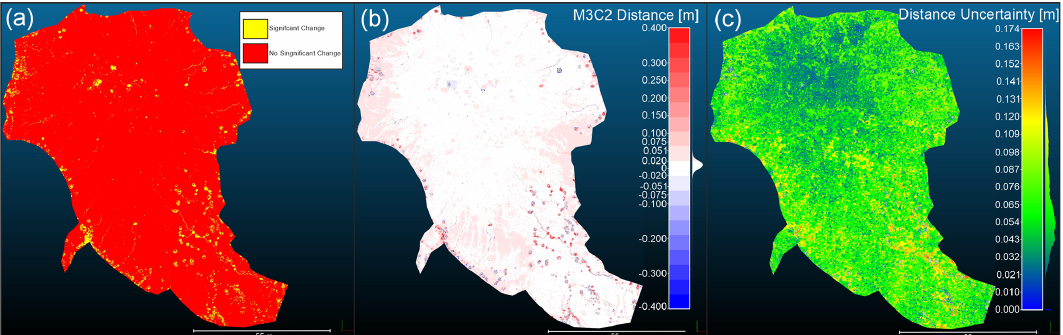
Figure 10. Point clouds resulting from M3C2-PM processing – comparison between 29 July 2019 and 15 June 2020: (a) significant changes between the two point clouds with LOD %95 , (b) distances between the two point clouds and (c) uncertainty of the distance between the two point clouds. The reference system is WGS 84/UTM zone